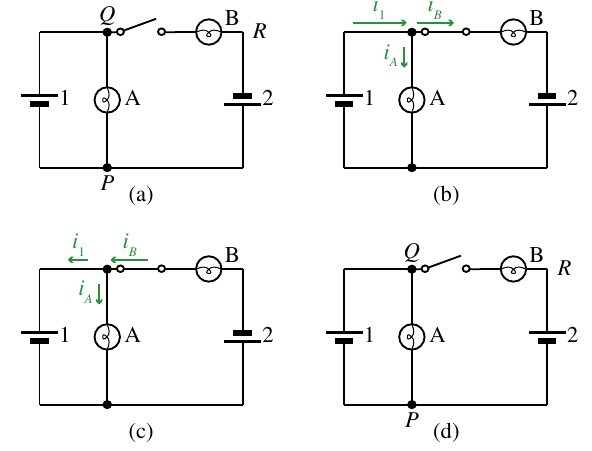
FIG. 9 (color online). Two circuits with multiple batteries in multiple loops used to develop the concept of potential and determine the direction of current. Circuits (a)–(c) are identical; in circuits (b) and (c), the length of the arrow indicates the magnitude of the current.